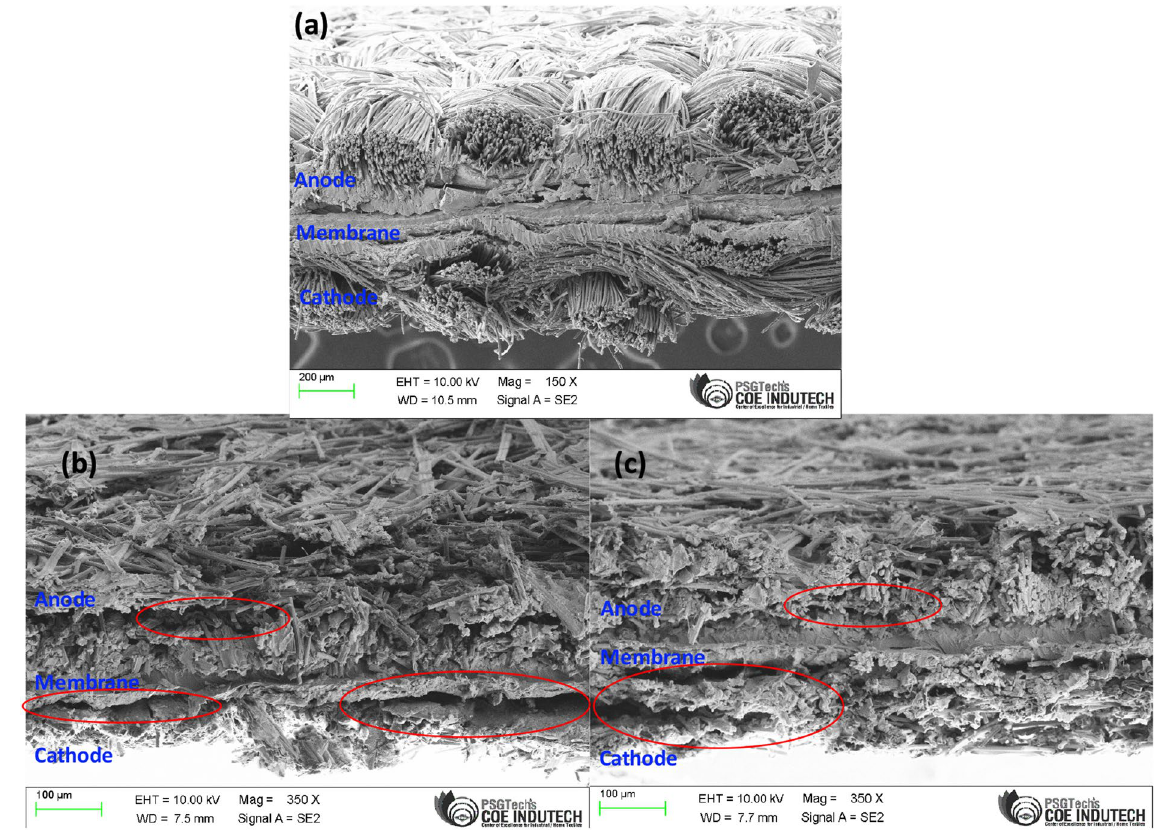
Figure 6. Cross-section FESEM image of ( a ) Fresh MEA ( b ) DLC1 and ( c )